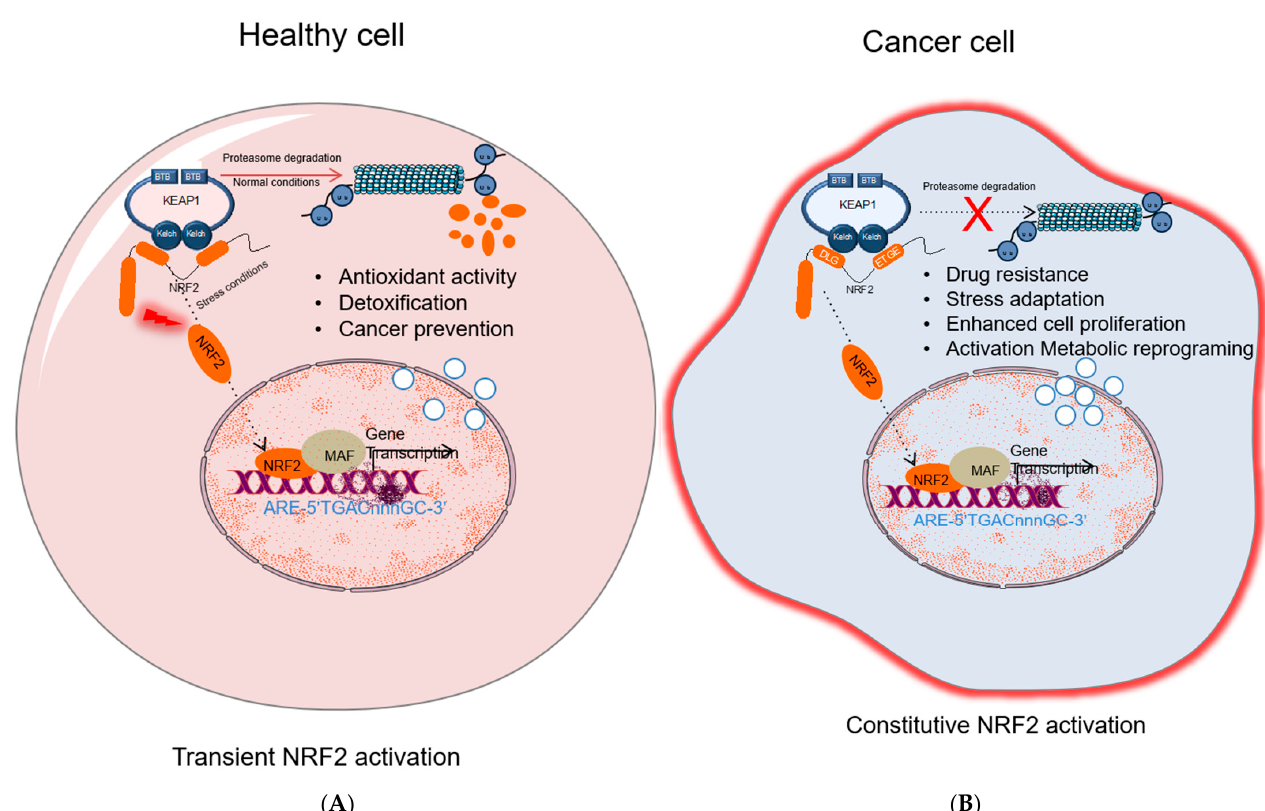
Figure 2. NRF2 activation in healthy and cancer cells. ( A ) In healthy cell, under normal conditions NRF2 level is inhibited by KEAP1-mediated proteasomal degradation; under stress conditions, NRF2 dissociates from KEAP1, accumulates in nucleus and activates cytoprotective gene expression. ( B ) In cancer cells, different molecular mechanisms cause constitutive NRF2 activation that results in drug resistance, stress adaptation, cells proliferation, and activation of metabolic reprogramming and induces expression of genes related to tumor progression. NRF2, nuclear factor erythroid 2-related factor 2; KEAP1, Kelch-like ECH-associated protein 1; MAF, small musculoaponeurotic fibrosarcoma protein; Pol II; RNA polymerase II; ARE: antioxidant response element.